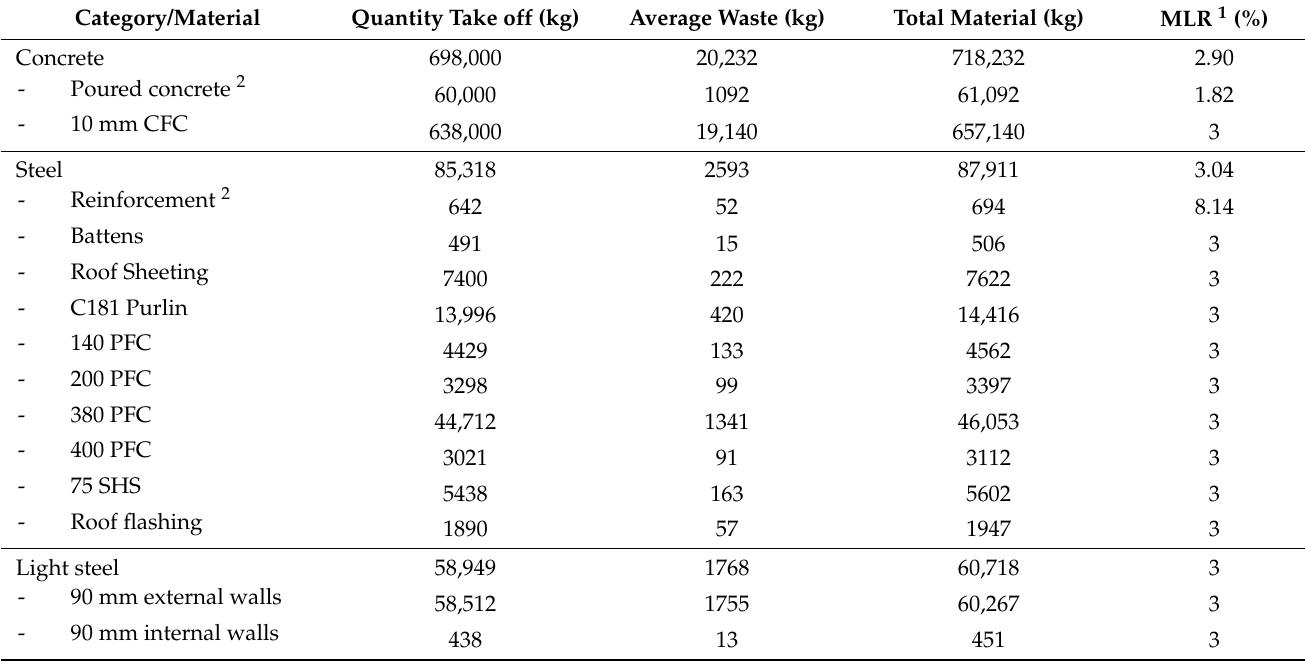
Table 8. Average waste generation for Case B modular